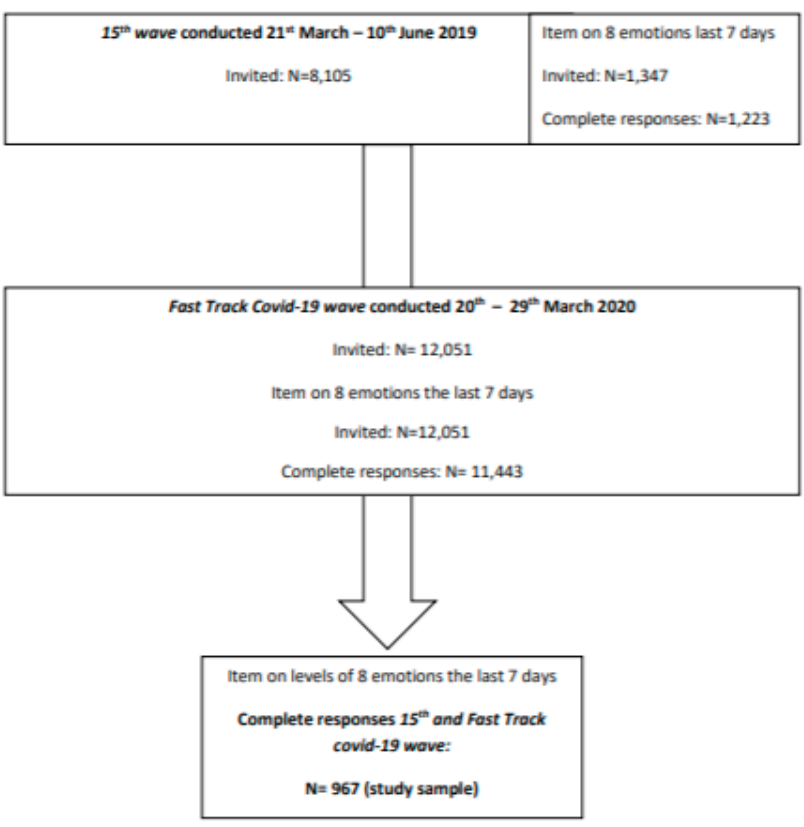
Figure 1. Flowchart of participants in the Norwegian Citizen Panel .